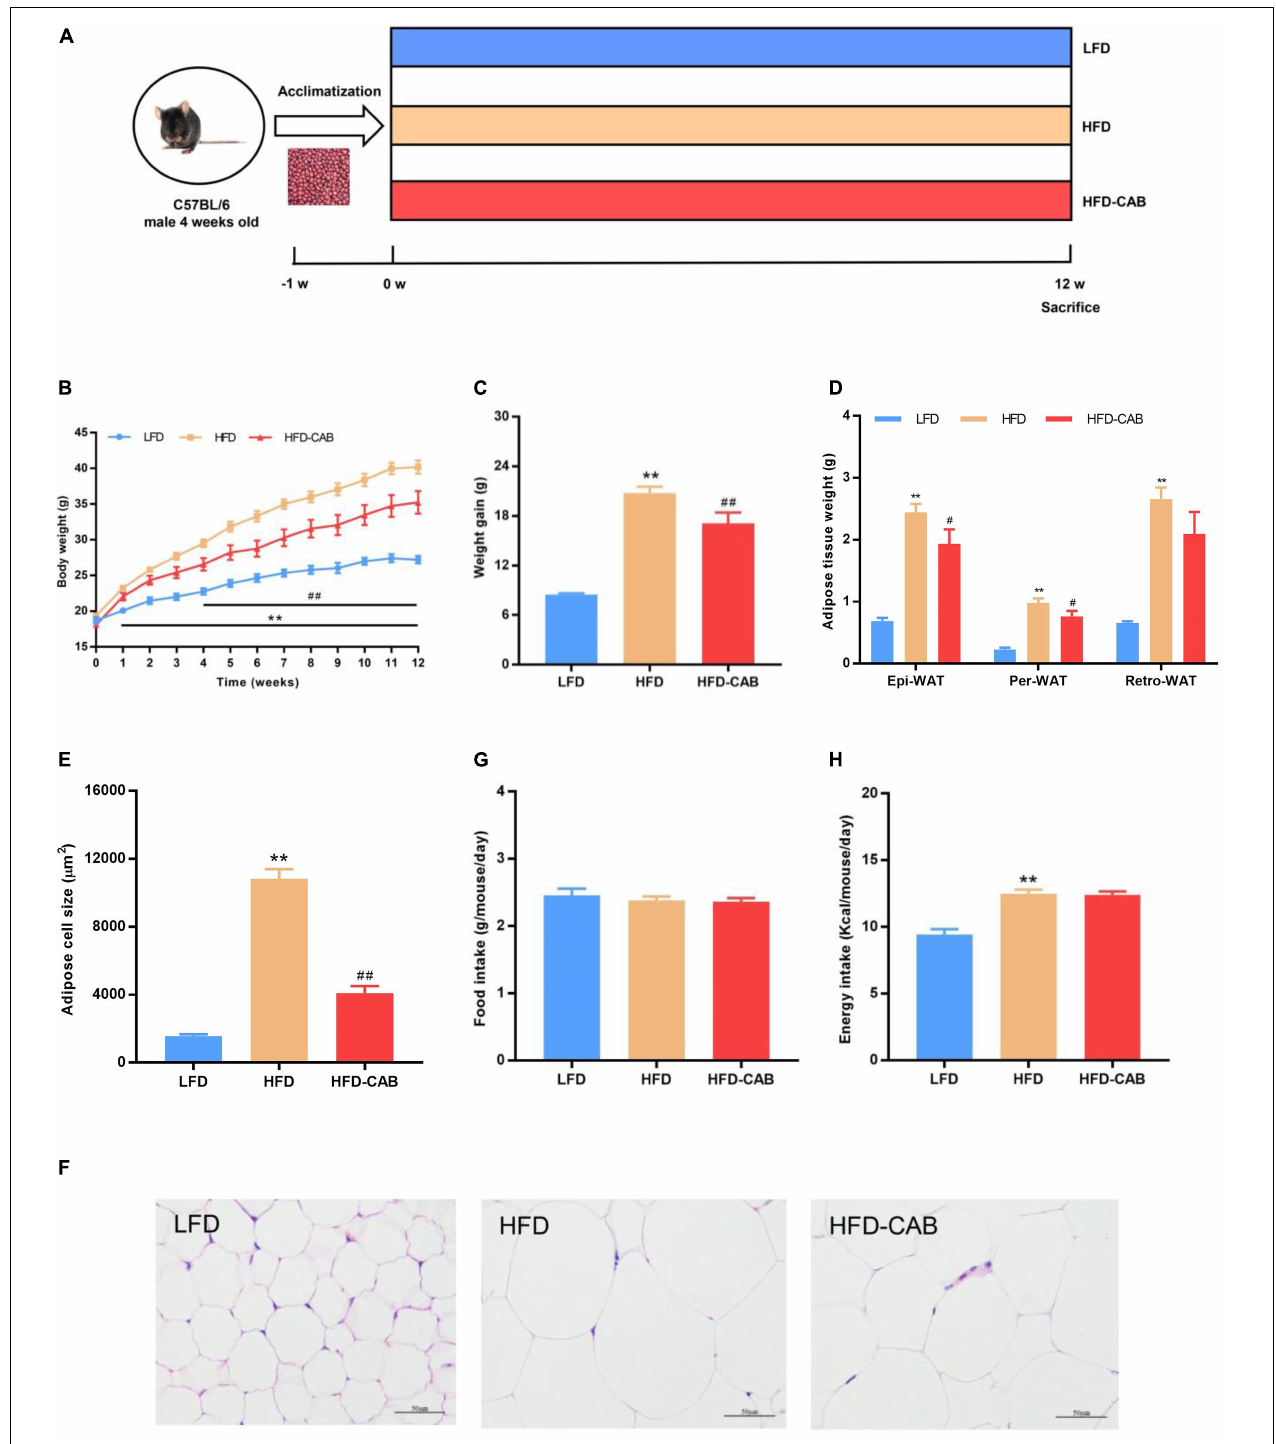
FIGURE 1 | Cooked adzuki bean reduces HFD-induced body weight gain and lipid accumulation in mice. (A) Experimental protocol and design, (B) Body weight time courses, (C) Weight gain, (D) Adipose tissue weight, (E) Adipose cell size, (F) H&E staining of Epi-WAT sections, (G) Food intake, and (H) Energy intake. Data presented as mean ± SEM, n = 7 per group. ** P < 0.01 vs. LFD; # P < 0.05 and ## P < 0.01 vs. HFD. Epi-WAT epididymal fat; Per-WAT perirenal fat; Retro-WAT retroperitoneal fat; LFD, low-fat diet; HFD, high-fat diet; HFD-CAB, high-fat diet supplemented with cooked adzuki bean.